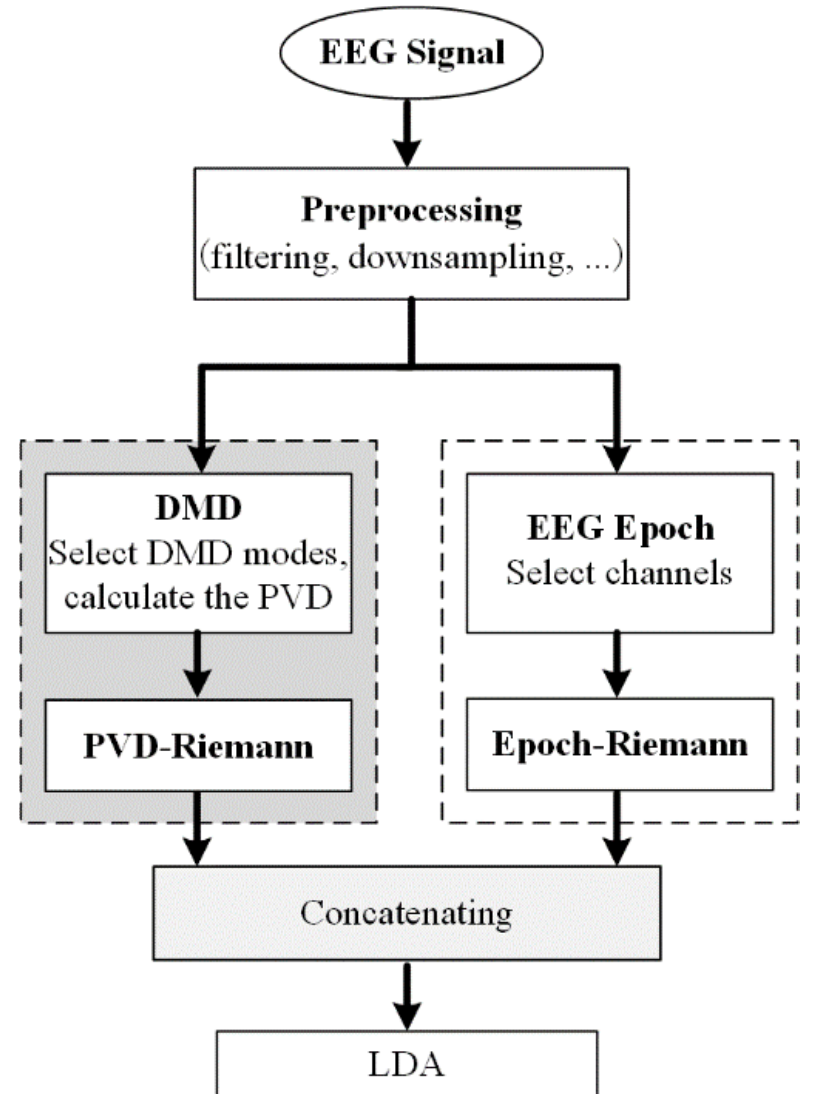
Figure 2. The flowchart of the classification method based on DMD phase information and Riemann